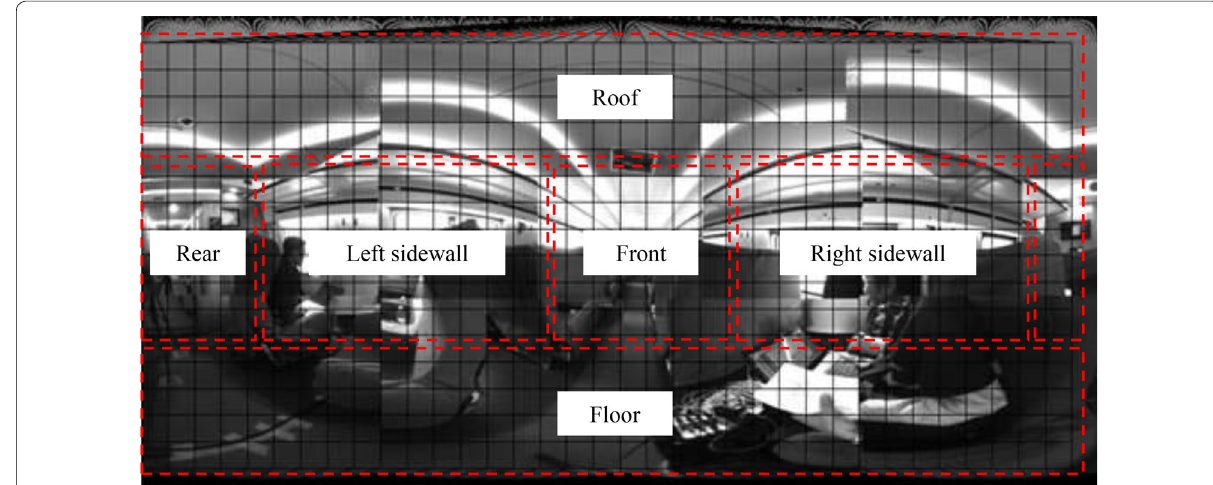
Figure 8 Different areas at the end of the first coach